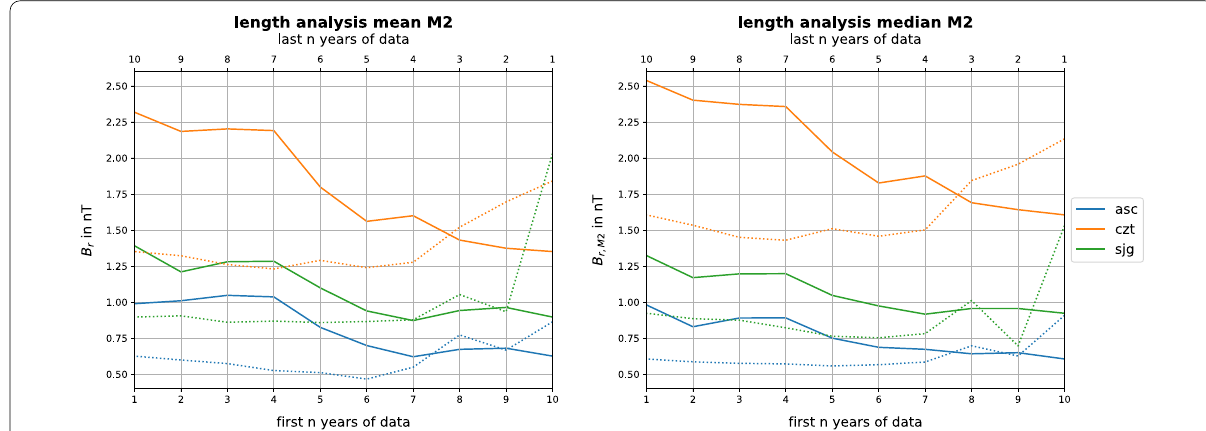
Fig. 3 Oceanic M2 tide induced magnetic field amplitudes in dependence of analyzed time series length at all three analysed coastal magnetometer stations. The amplitudes were obtained after phasing and averaging the data with the mean (left) and the median (right). Solid lines show the results for the analysis conducted on the first n years of the 10 year time series (corresponding to lower x‑axis), while the dotted lines show the analysis results for the last n years of data (corresponding to upper